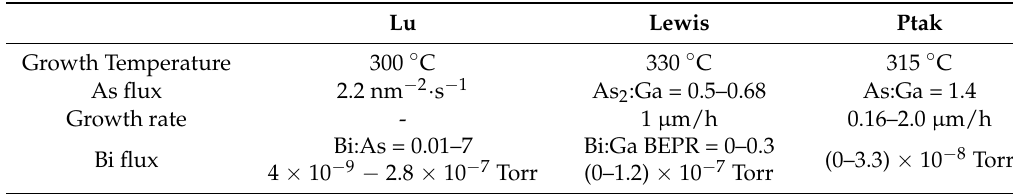
Figure 8. Bi content as a function of Bi flux grown at different growth rates. Reproduced from Reference [129]. Table 4. Comparison of growth parameters used in the three